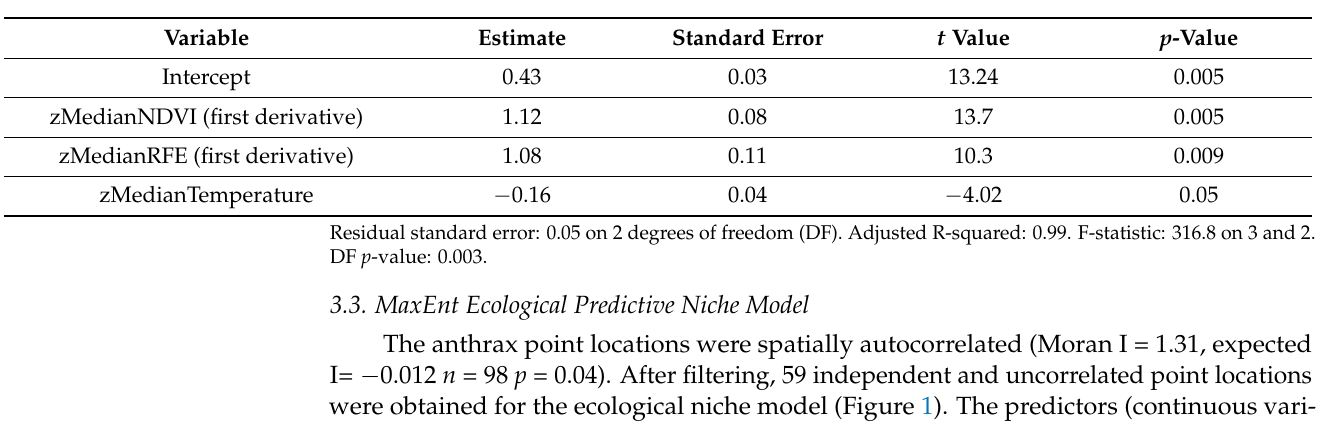
Table 1. Results of the linear regression between standardized median number of anthrax outbreaks: first derivative of standardized median rainfall, first derivative of standardized median NDVI and standardized median temperature by month during the period January–June.